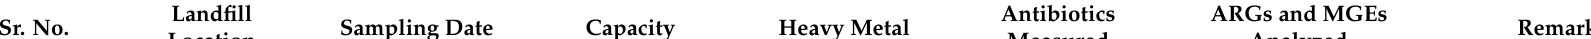
Table 1. Detection of antibiotic resistance genes (ARGs) and metal resistance genes (MGEs) in the leachate samples of different landfill sites. Sr.